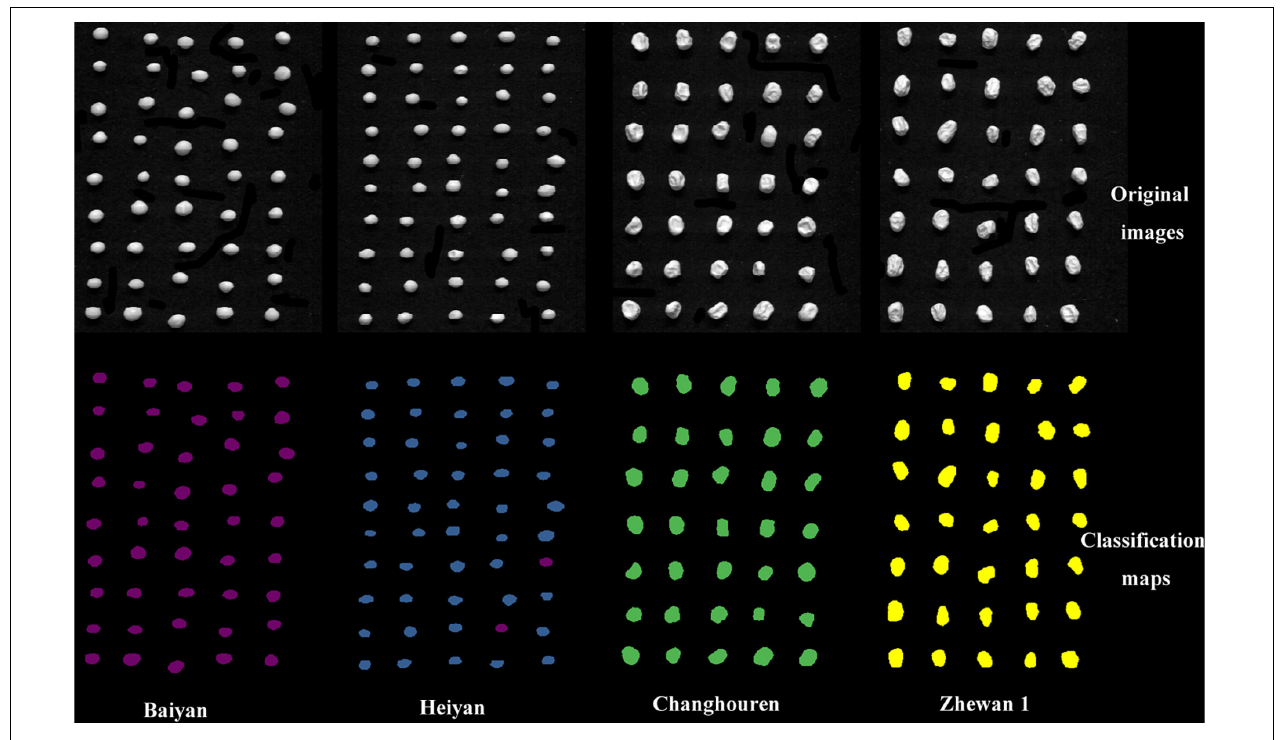
FIGURE 7 | The classification visual maps of pea